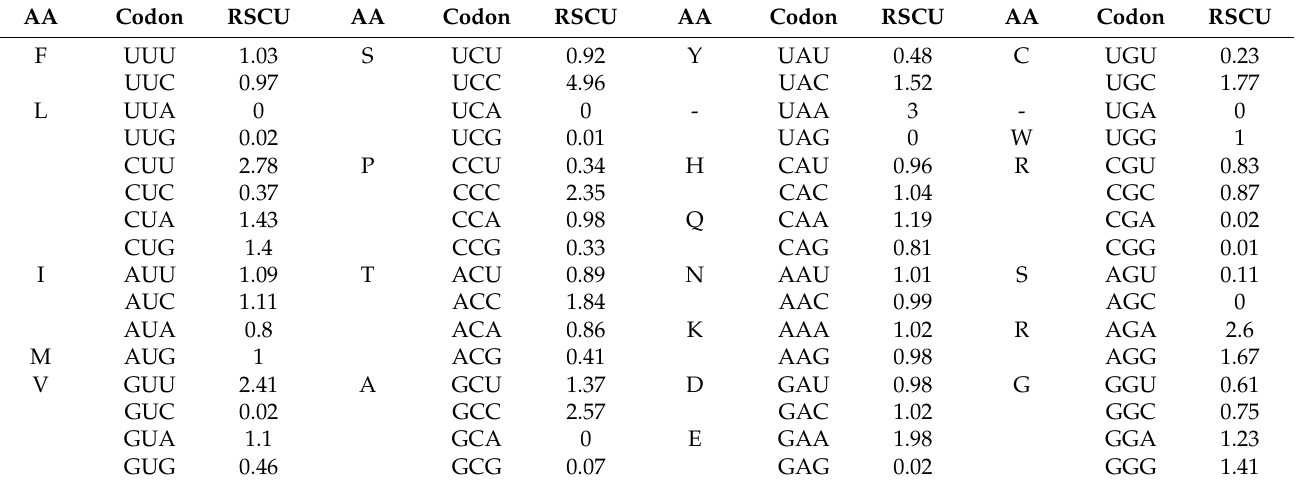
Over-represented codons (RSCU value > 1.0) and under-represented codons (RSCU value < 0.5) in Cap gene of P1